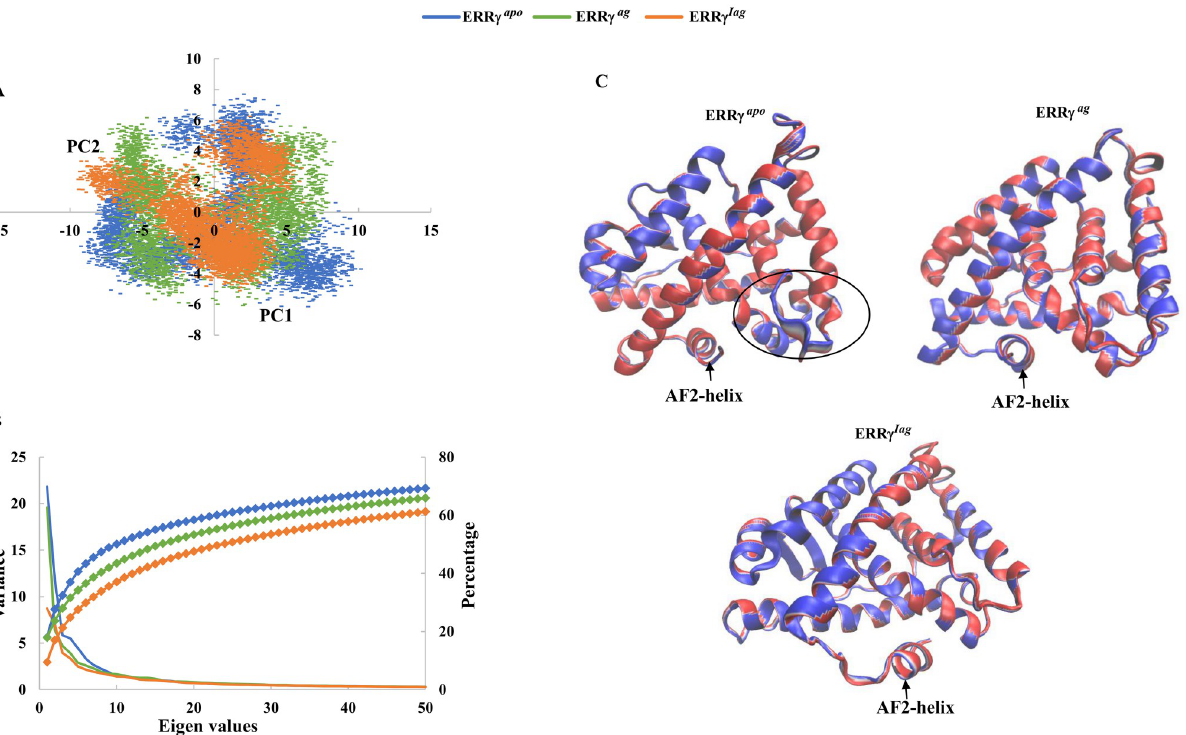
Fig 6. Principal component analysis of ERR γ apo , ERR γ ag and ERR γ iag : (A) Principal component analysis of ERR γ apo , ERR γ ag and ERR γ iag projected by PC1 and PC2 onto the phase space. (B) The first 50 eigenvectors, corresponding to the best eigenvalue principal components, are represented in the plot along with their associated cumulative fluctuations. (C) The conformational changes, minimum (red) to maximum (blue) observed for ERR γ apo , ERR γ ag , and ERR γ iag using PC1 and PC2 with 30 conformations extracted using the extreme module. The black circle represents the large conformational changes in the loop between helix-8 and helix-9 in ERR γ apo